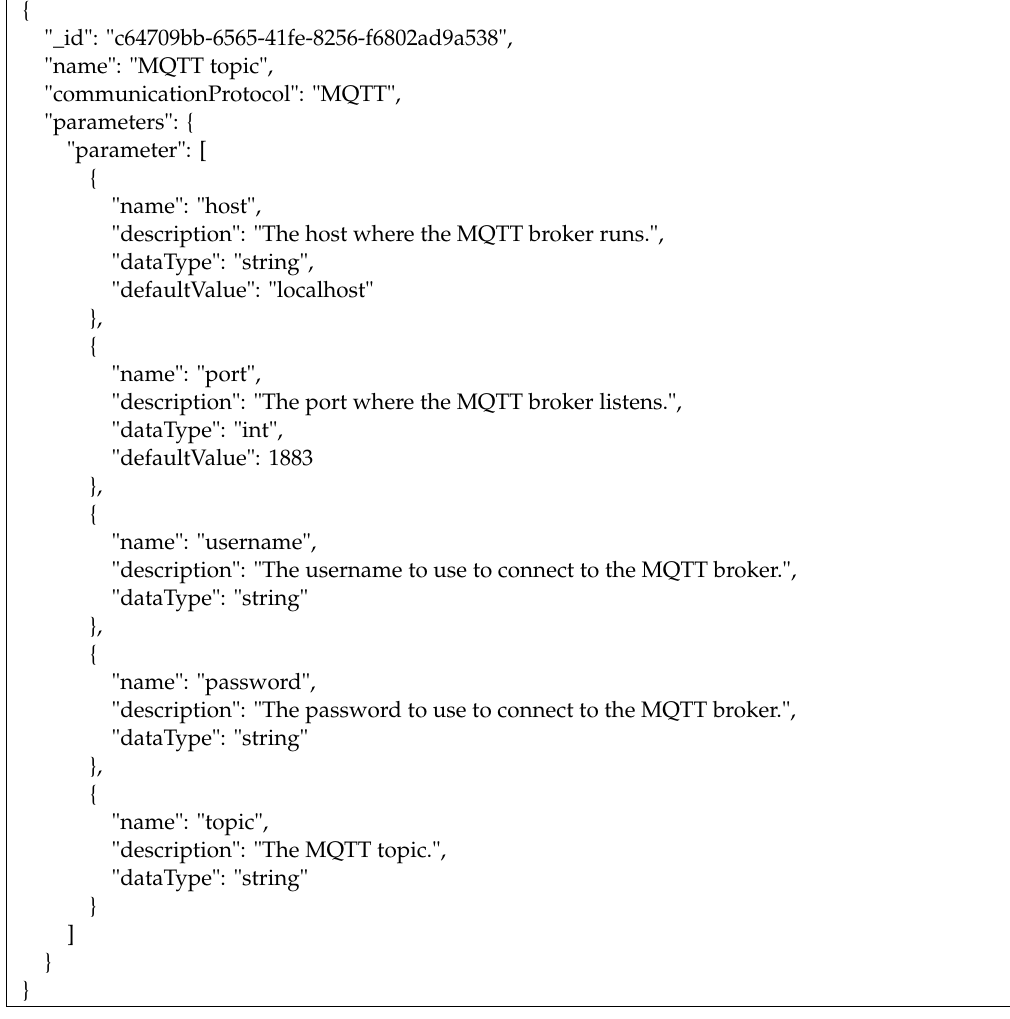
Table 1. Data Interface (DI) Modelling.